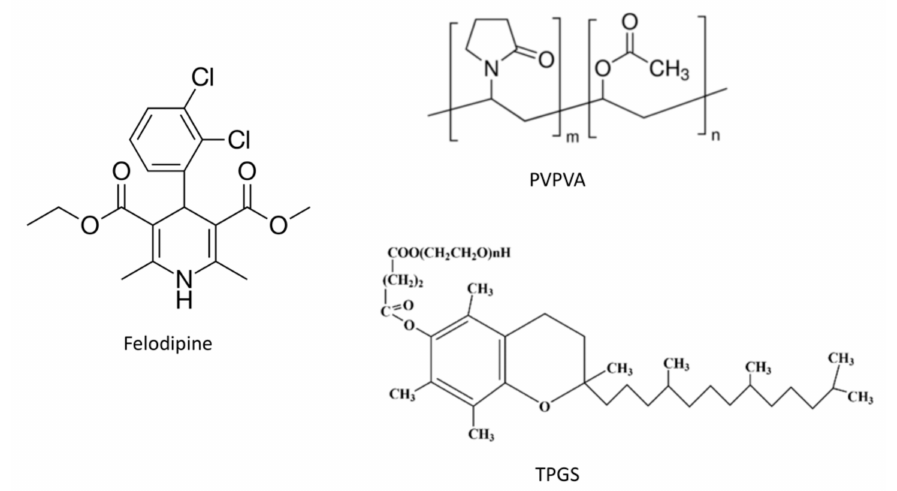
Figure 1. Chemical structures of felodipine (drug), PVPVA (polymer), and TPGS